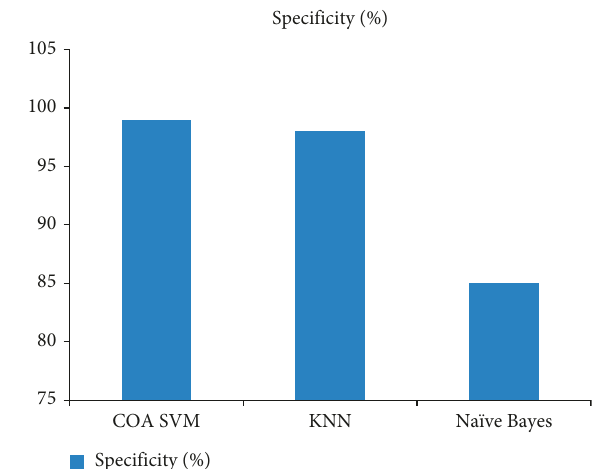
Figure 4: Specificity of classifiers for perishable food